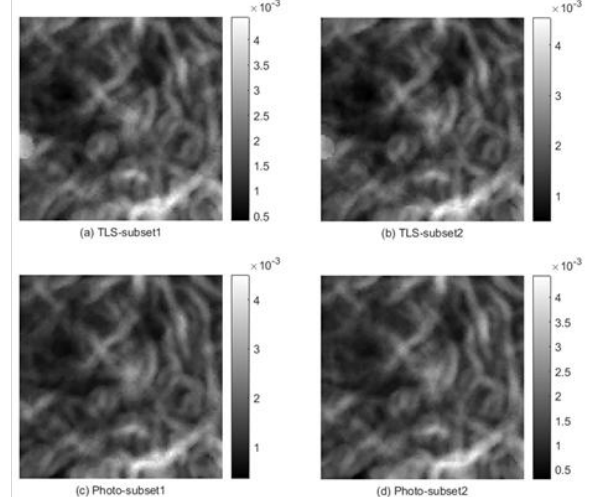
Figure 4. The RMSH for the window size of 76 mm (i.e. 7 times the average data spacing).